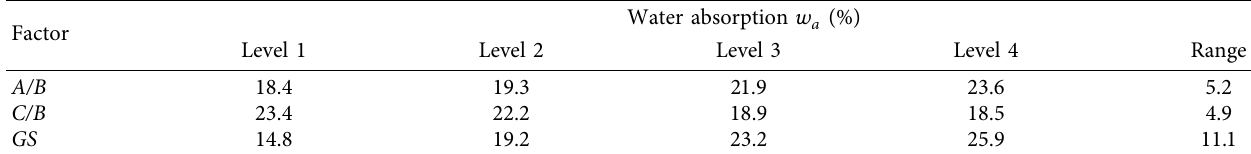
Table 6: Extremum difference analysis of water